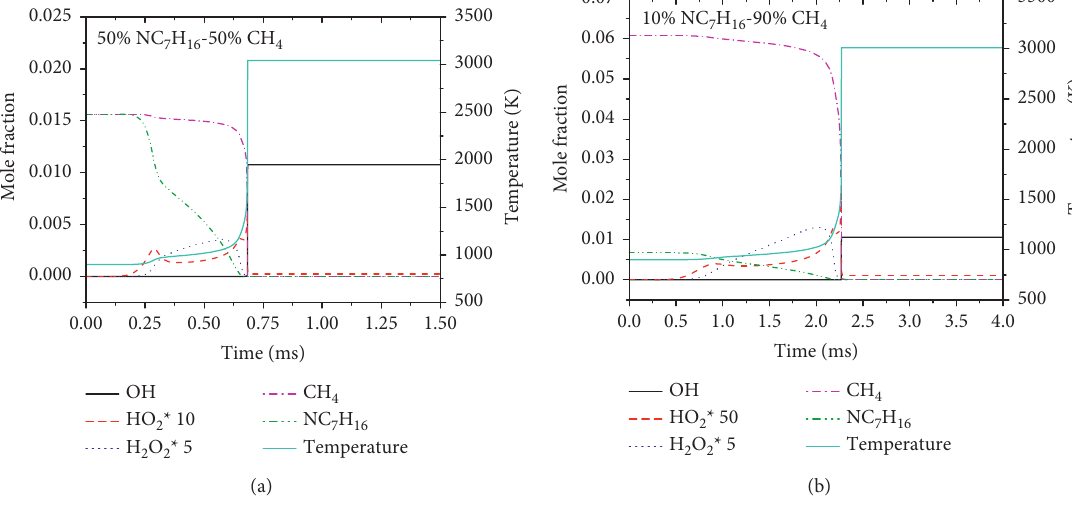
Figure 5: Species and temperature evolution of different methane/n-heptane mixing ratios at T � 900K ϕ � 1, and p � 40